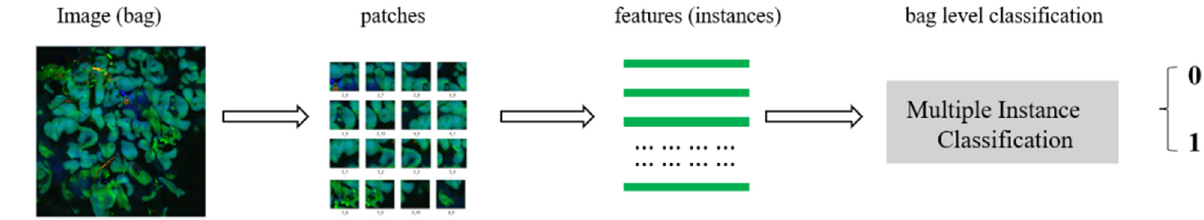
Figure 3. The flowchart of the multiple instance classification.